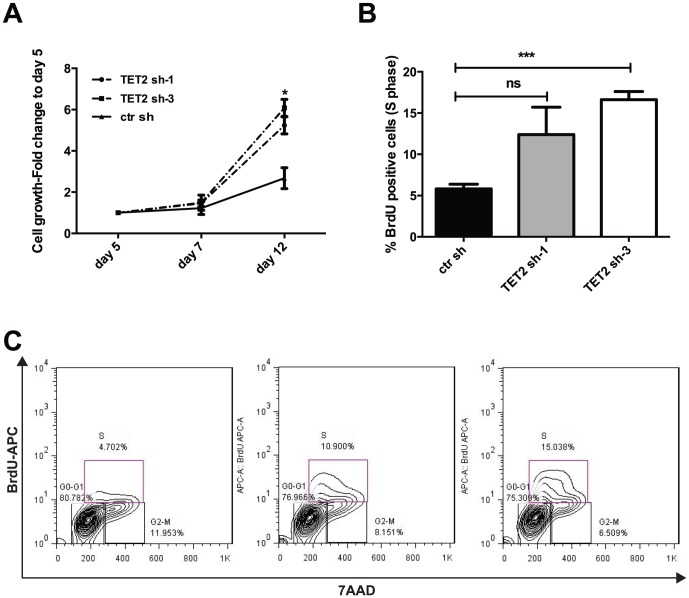
Increased proliferation of HMC-1.2 cells after knock down of TET2.
A) HMC-1.2 cells were treated with two hairpins against TET2 (TET2 sh-1 and TET2 sh-3) or a control shRNA (ctr sh). Cell growth was calculated using the CellTiter-Glo assay from Promega. Data are presented as fold change relative to day 5 after transduction. Values represent mean ±SEM, n = 3 independent experiments. *P<.05. B) Percentage of cells in S-phase determined by BrdU incorporation in HMC-1.2 cells treated with TET2 sh-1 and sh-3 compared to a control hairpin. Values are mean ±SEM. n = 3 independent experiments, ***P<.001, ns =  not significant. C) Representative FACS plots showing BrdU incorporation in relation to cell cycle stages in HMC-1.2 cells infected with control hairpin (ctr sh) compared with TET2 sh-1 and TET2 sh-3.